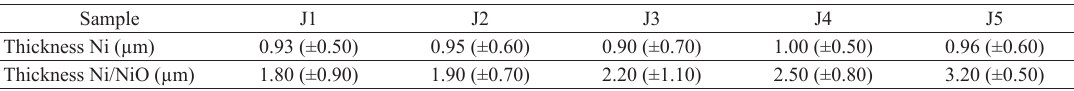
Table 5. Mean and standard deviation of the thickness of the Ni and Ni/NiO coatings. Sample